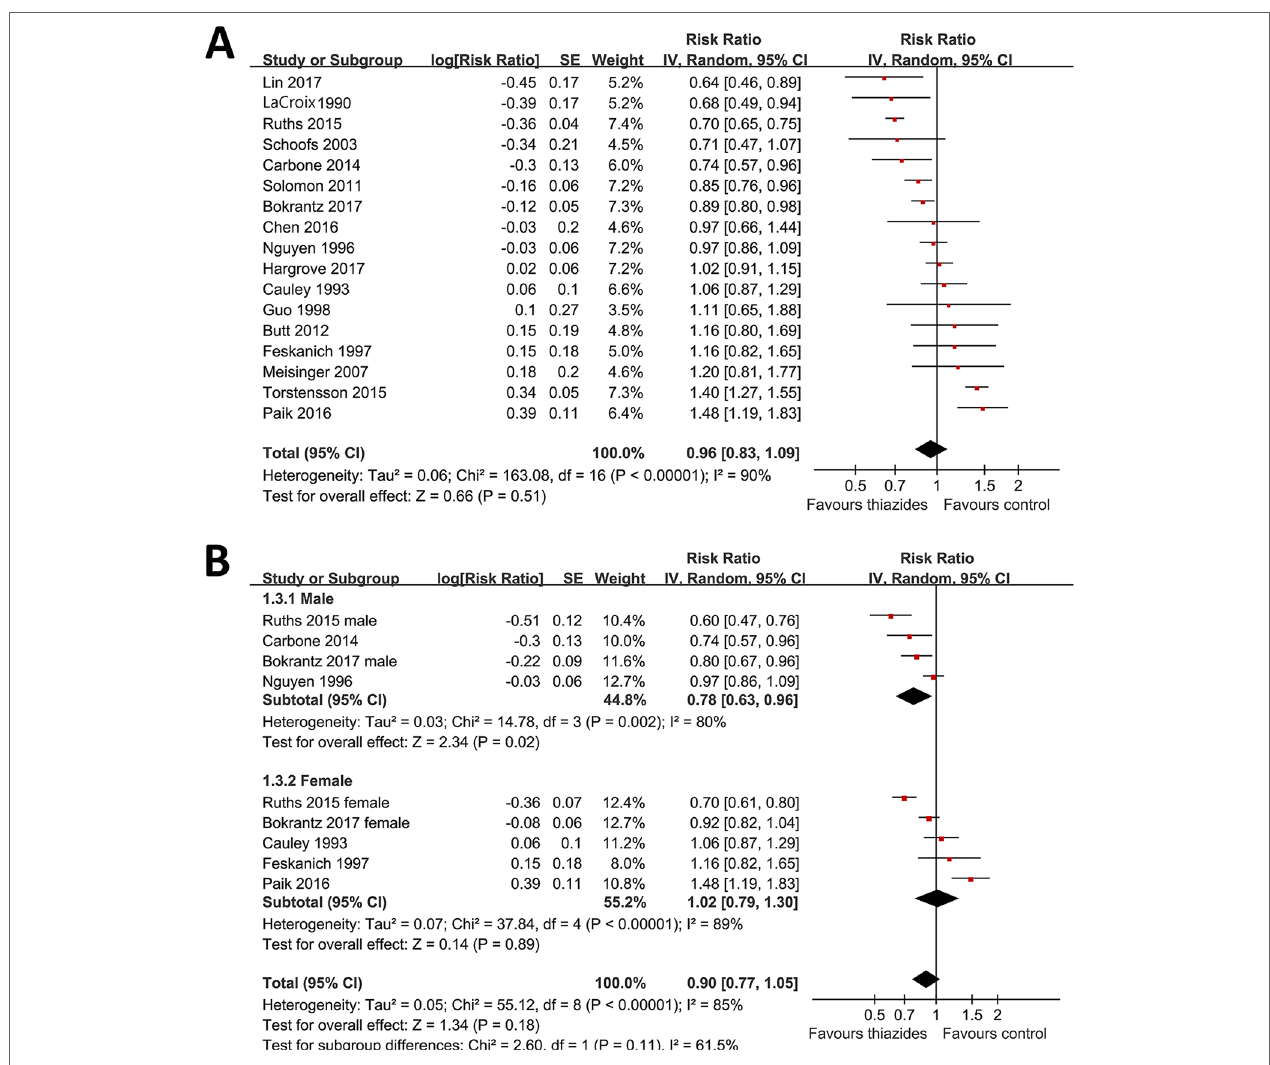
FIGURe 2 | Forest plots for the meta-analysis of the association between the use of thiazide diuretics and the incidence of fracture. (A) Forest plots for the overall participants; (B) forest plots for the subgroup analysis by sex.